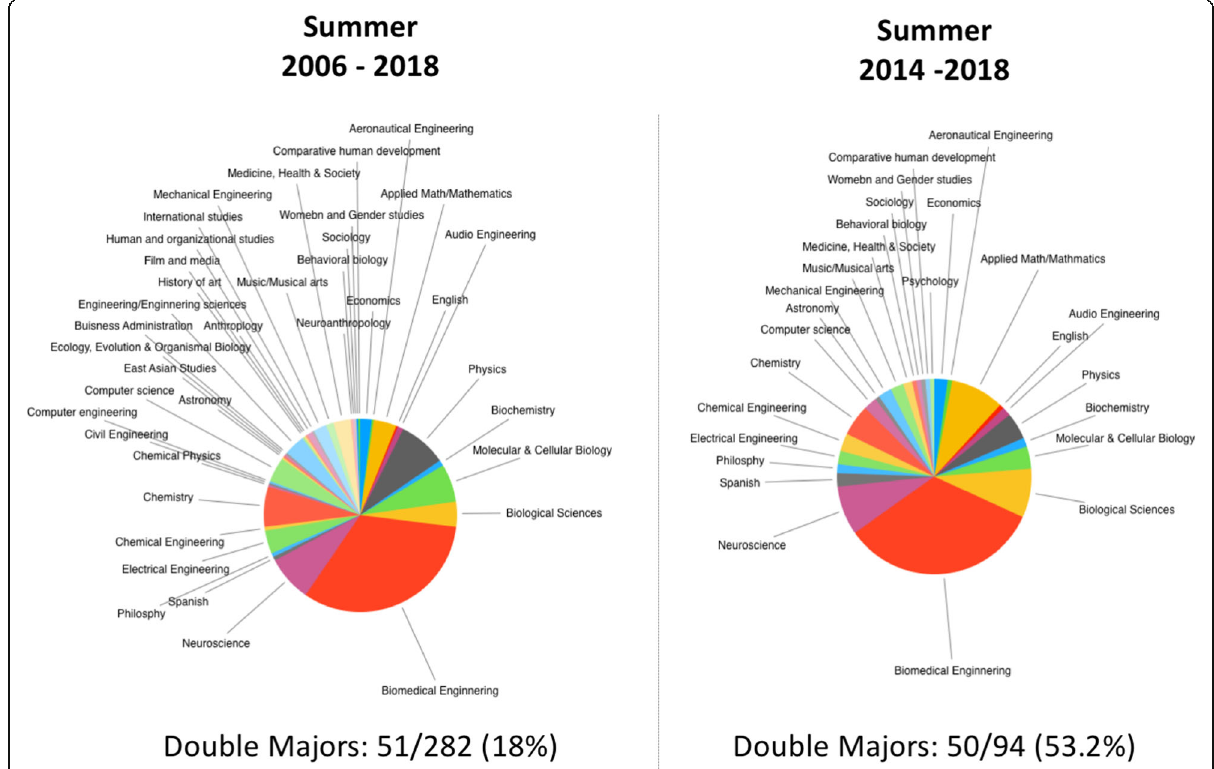
Fig. 2 Discipline diversity. On the left, the distribution of student majors is shown, since the program was initiated in the summer of 2006 through the summer of 2018 (282 students). On the right, the student major distribution is shown from the summer of 2014 through the summer of 2018 (94 students). This time period represents the students who participated in VIX. In this subpopulation, there was a significant increase in double majors (50/94; 53.2%). The program ’ s overall discipline diversity is shown in the left panel of Fig. 2: Biomedical Engineering (102), Physics (25), Neuroscience (24), Chemistry (21), Molecular & Cellular Biology (20), Biological Sciences (13), Computer Science (13), Applied Math/Mathematics (12), Electrical Engineering (12), Engineering/Engineering Sciences (11), Medicine, Health & Society (9), Mechanical Engineering (7), Economics (6), Music/Musical Arts (4), Audio Engineering (3), Biochemistry (3), Human and Organizational Studies (3), Chemical Engineering (2), Spanish (2), Philosophy (2), Aeronautical Engineering (1), Anthropology (1), Astronomy (1), Behavioral Biology (1), Business Administration (1),Chemical Physics (1), Civil Engineering (1), Comparative Human Development (1), Computer Engineering (1), Ecology, Evolution & Organismal Biology (1), East Asian Studies (1), English (1), Film and Media (1), History of Art (1), International Studies (1), Neuroanthropology (1), Sociology (1), and Women and Gender Studies (1). The interviewed cohort matches this diversity, with majors in Biomedical Engineering (45), Biological Sciences (11), Neuroscience (11), Applied Math/Mathematics (12), Chemistry (7), Physics (6), Molecular & Cellular Biology (5), Chemical Engineering (4), Economics (3), Electrical Engineering (3), Mechanical Engineering (3), Music/Musical Arts (3), Spanish (3), Audio Engineering (2), Biochemistry (2), Medicine, Health & Society (2), Philosophy (2), Aeronautical Engineering (1), English (1), Computer Science (3), Astronomy (1), Behavioral Biology (1), Comparative Human Development (1), Sociology (1), Psychology (1), and Women and Gender studies